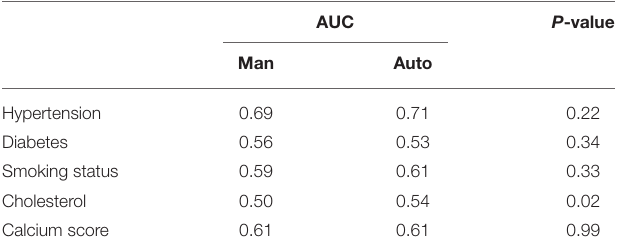
TABLE 6 | Area under the ROC curve (AUC) comparisons from the 1,052 LV shape association studies using different contours: manual (Man) and deep learning (Auto).